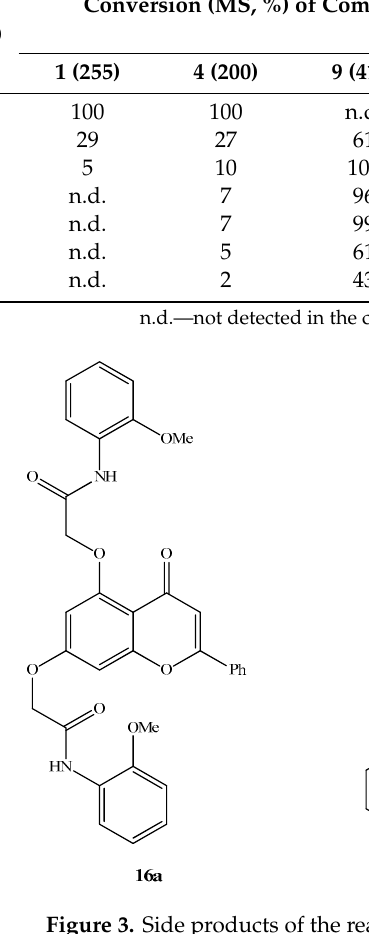
Figure 3. Side products of the reaction between 1 and 4 .